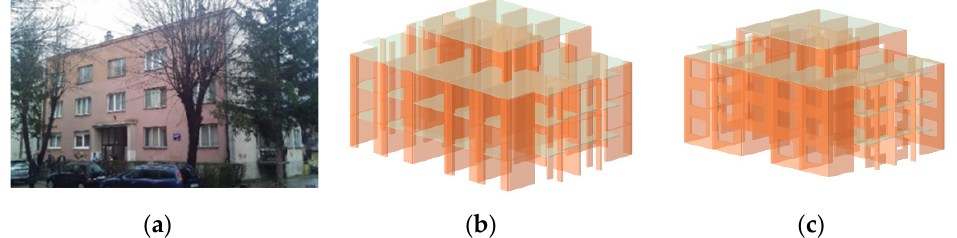
Figure 19. 3D numerical models: ( a ) actual building; ( b ) Cantilever model, and ( c ) Equivalent Frame Model (EFM).